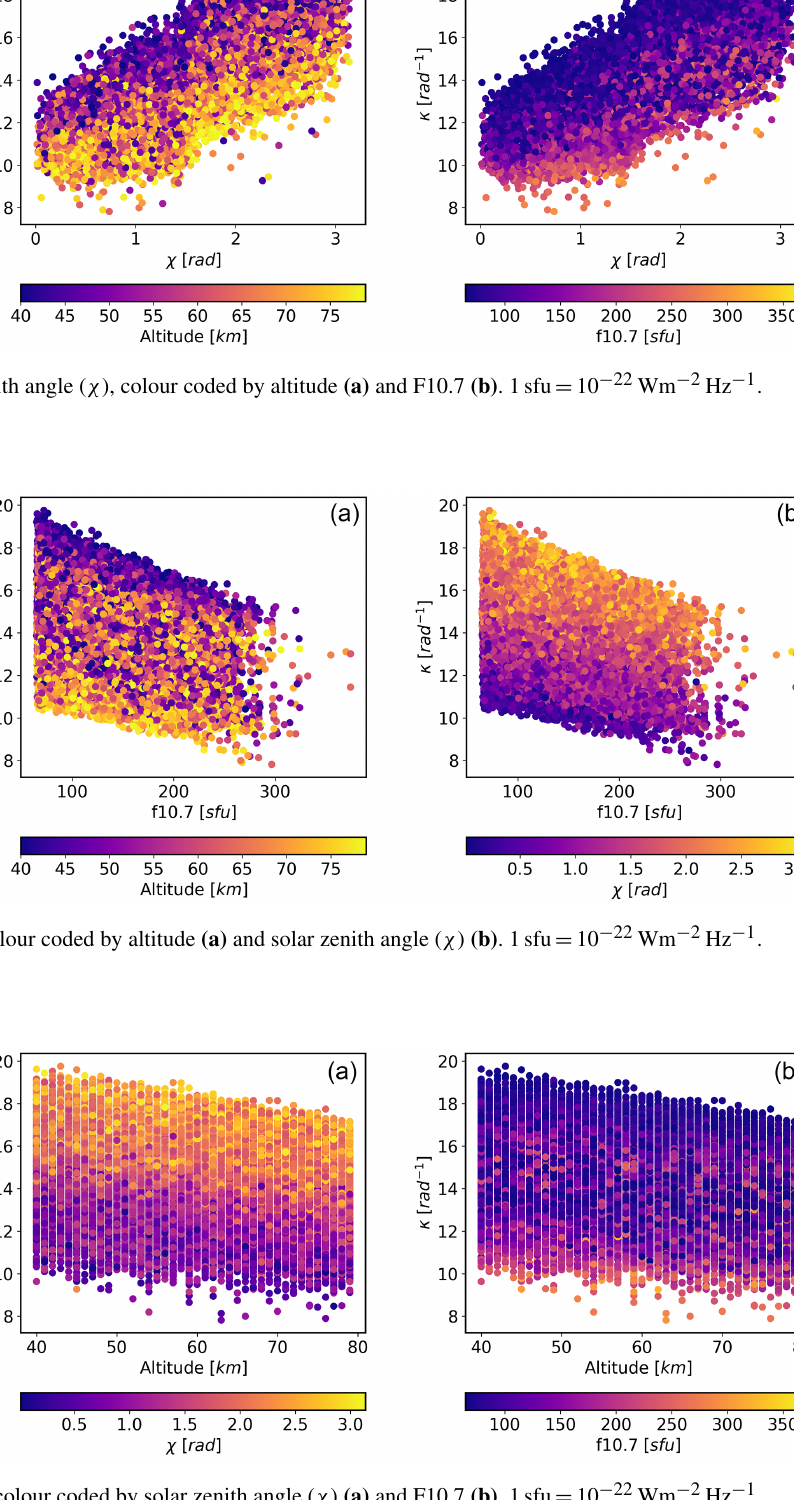
Figure 13. κ vs. altitude, colour coded by solar zenith angle ( χ ) (a) and F10.7 (b) . 1sfu = 10 − 22 Wm − 2 Hz − 1